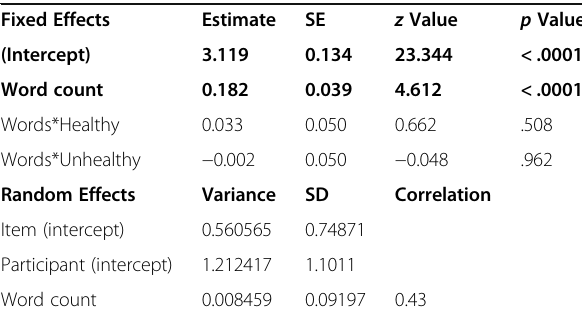
Table 5 Experiment 2: Effect of comment length